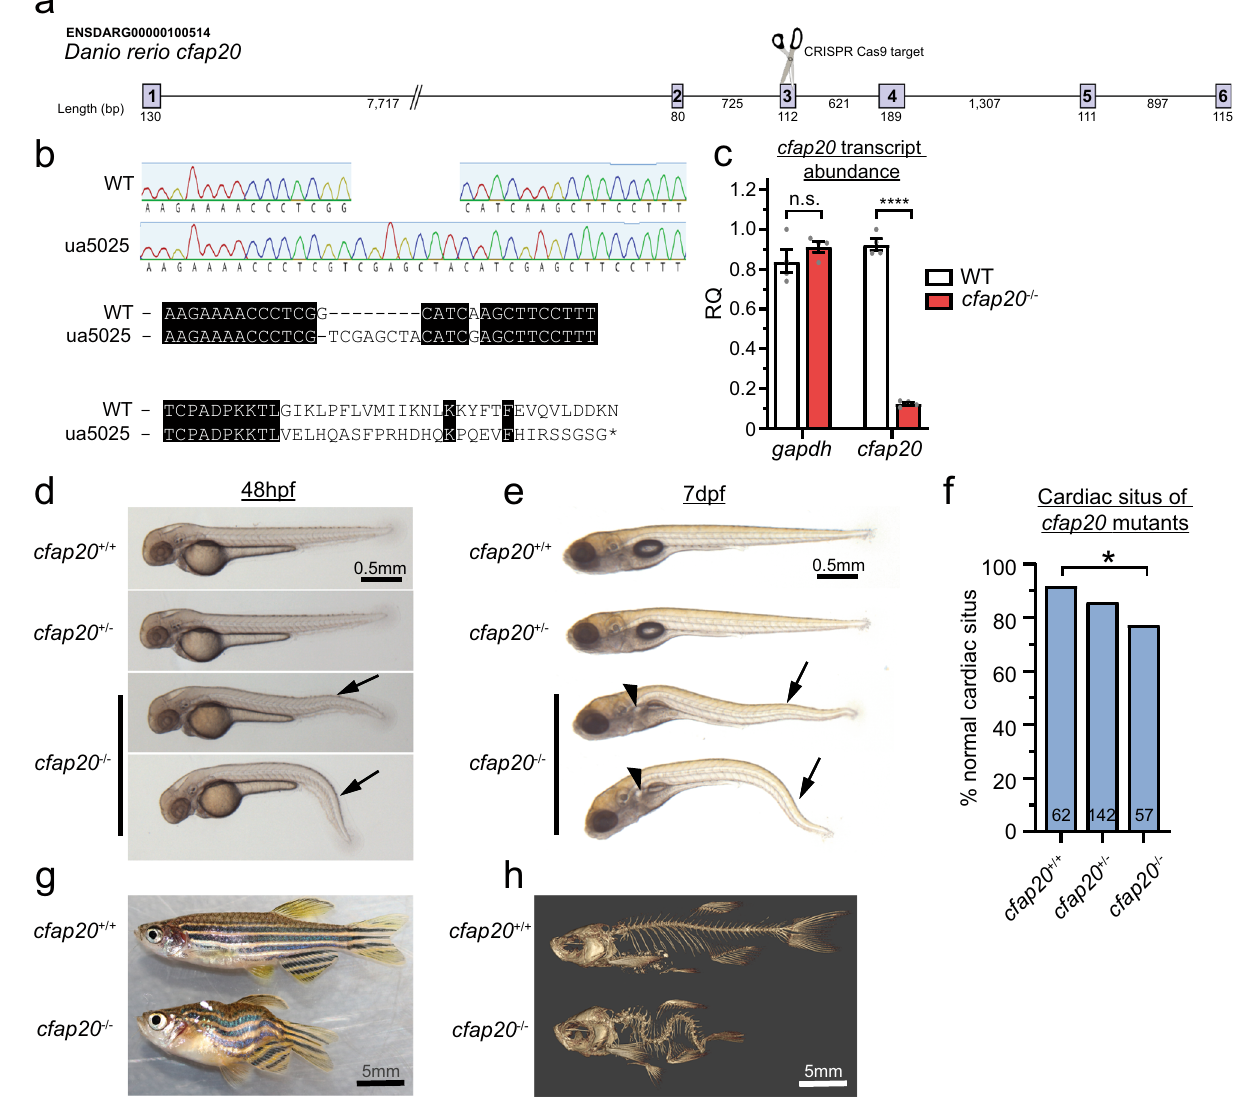
Fig. 2 | Zebra fi sh cfap20 mutants display developmental phenotypes char- acteristic of a motile ciliopathy. a Schematic of CRISPR/Cas9 strategy targeting exon3. b The cfap20 ua5025 allele ( cfap20 − / − ) has a 1bp deletion, 8bp insertion (c.209delGinsTCGAGCTA; p.Gly70Valfs*29) that produces a frameshift at residue 70 and predicts loss of the majority of this deeply conserved protein (see also SupplementaryFig.1). c cfap20 − / − mutantshavedramaticallyreducedabundanceof transcript compared to wildtype at 48h post fertilisation (hpf) ( n =4, error bars= SEM; two-tailed unpaired T-tests, gapdh P =0.2912; cfap20 P =1.54*10 − 7 ). d , e cfap20 − / − larvae exhibit anterior-posterior body axis kinks/ventral curvature